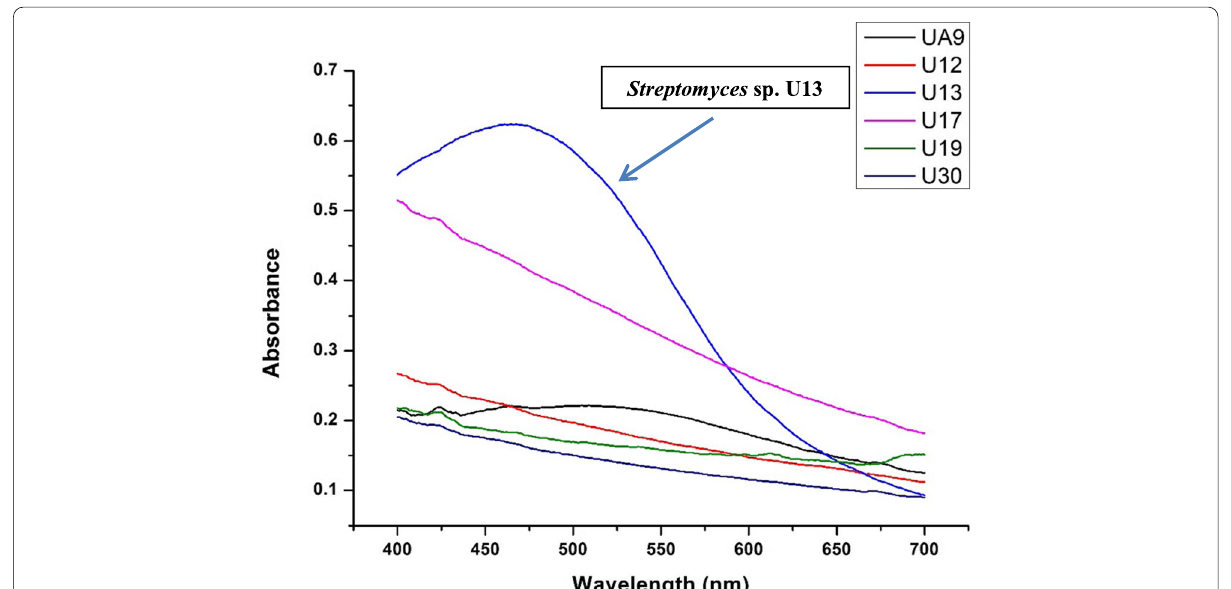
Fig. 3 UV–Vis scan of extracellular Ag NPs formed by the six tested actinomycete strains. Only Streptomyces sp. U13 actinomycete strain showed the characteristic absorption band of Ag